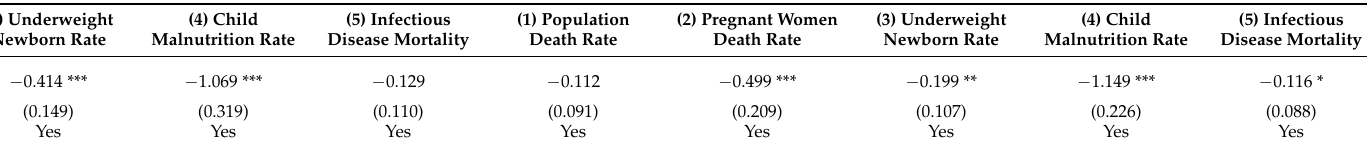
Table 6. Heterogeneous region: province pair in identical region vs. different regions (extended